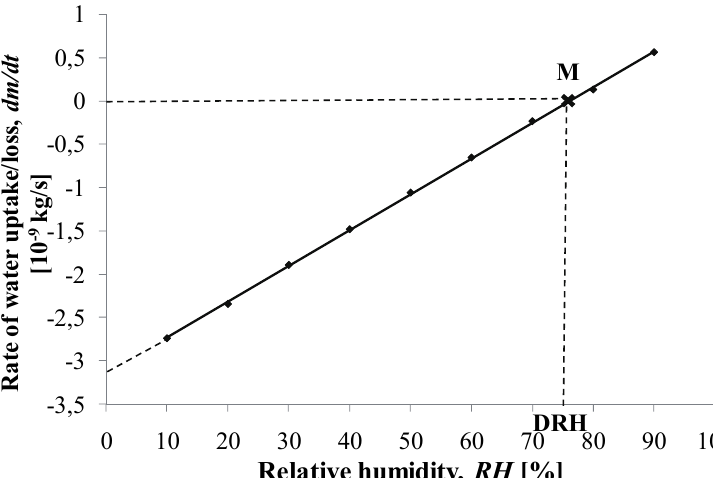
Fig. 7 Water uptake/loss rate at different constant relative humidities at 25 ℃ during partial dissolution followed by re- crystallization of NaCl; point M corresponds to DRH .